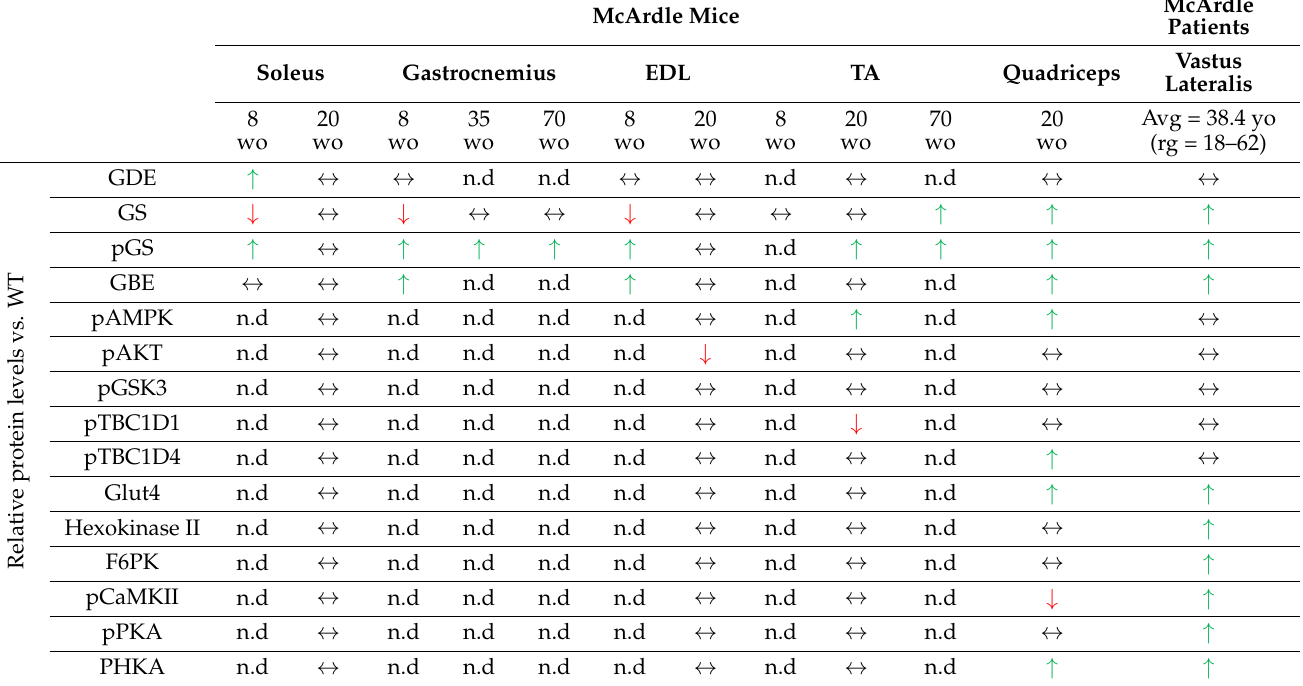
McArdle Patients